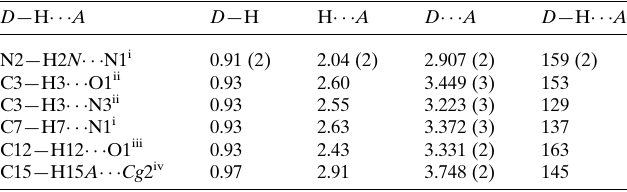
Table 4 Hydrogen-bond geometry (A˚ , (cid:3) ) for (II). Cg 2 is the centroid of the C8–C13 benzene ring.